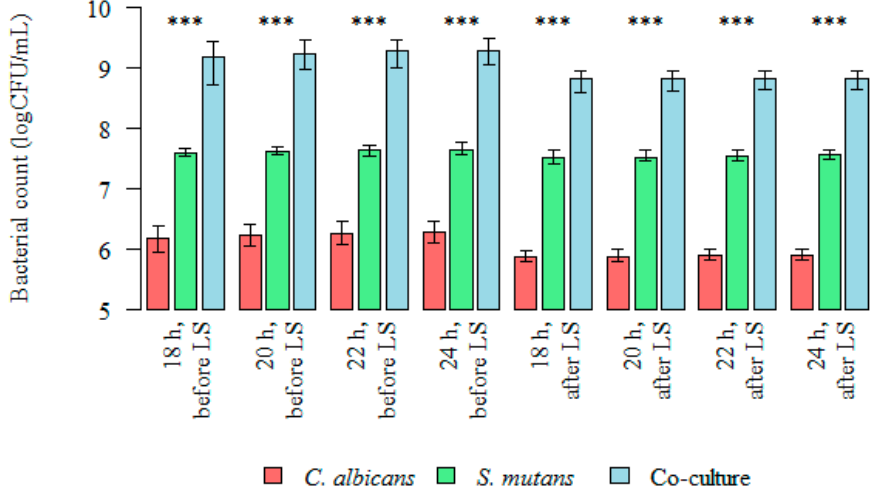
Figure 3. Intergroup differences between bacterial count (logCFU/mL), before and after Lactobacillus salivarius (HM6 Paradens, LS) administration. The Kruskal–Wallis test was used for dependent (repeated) measurements; p < 0.001; *** Dunn’s test (post-hoc test).